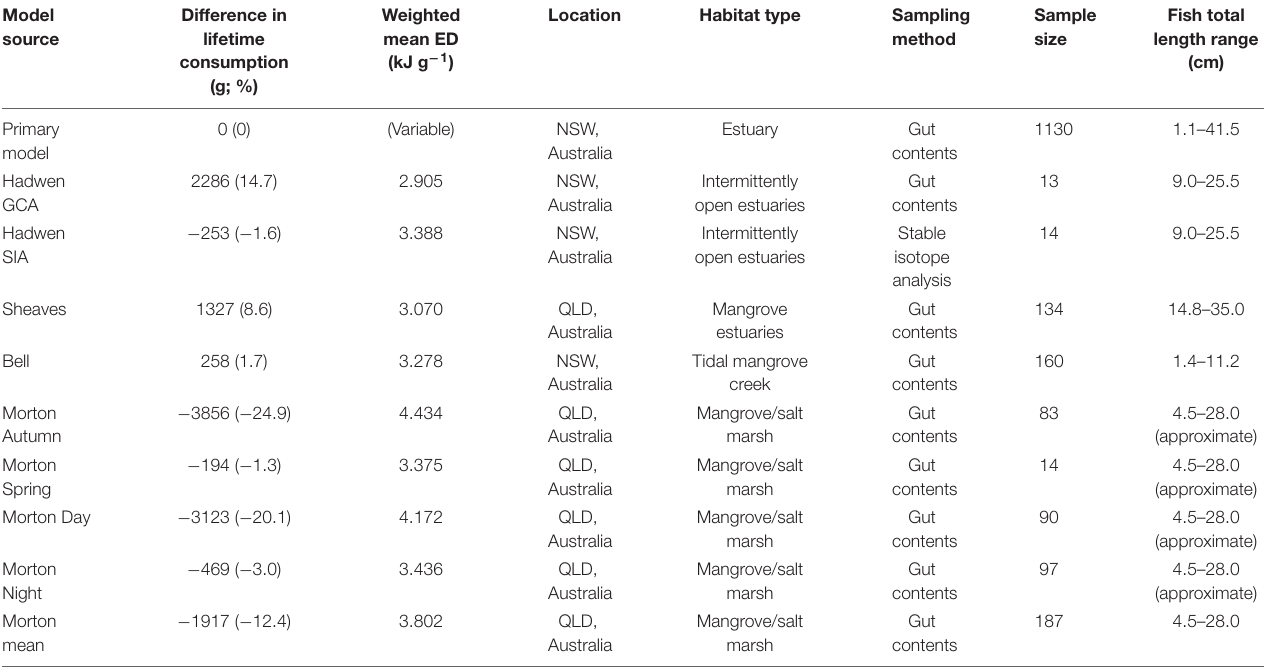
TABLE 3 | Details of the four studies (with nine data sets in total) from which prey composition was extracted and comparative bioenergetic model scenarios